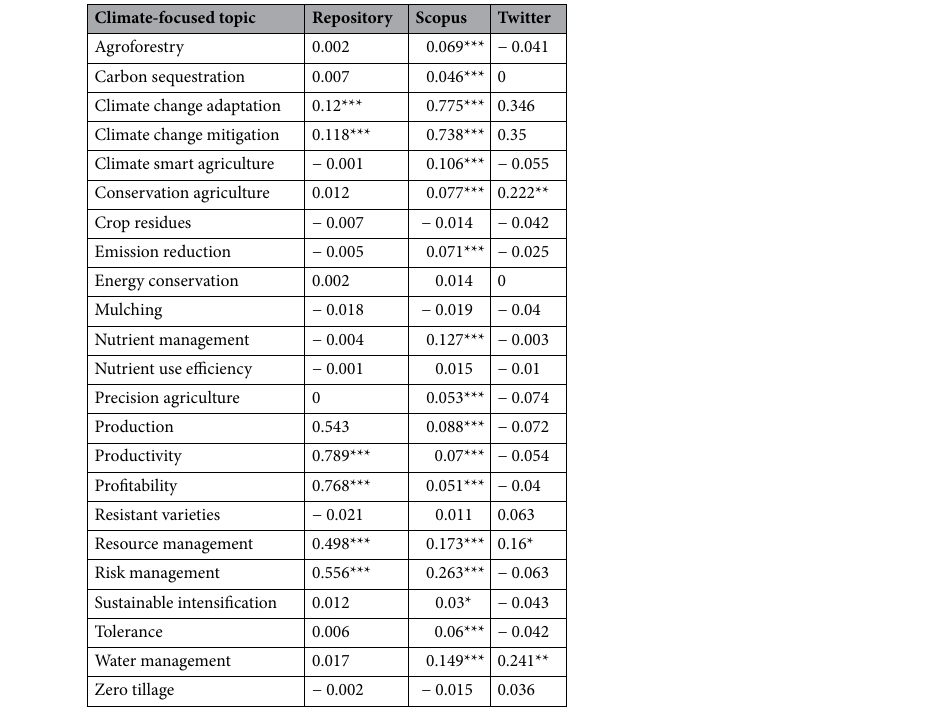
Table 4. Correlations between ‘Climate change’ and climate-focused topics identified in the datasets. *p < 0.10, **p < 0.05, ***p <